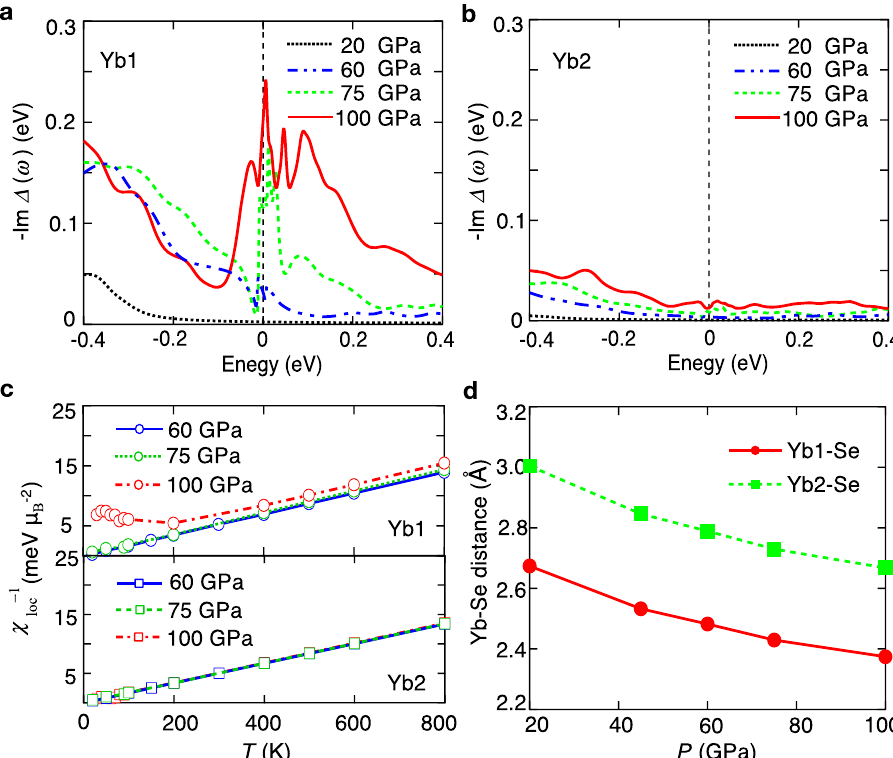
Fig. 3 Different properties of the two inequivalent Yb-ions. a , b Pressure evolution of the minus imaginary part of the hybridization function in real frequency on Yb1 and Yb2 ions from 20 to 100 GPa, obtained by DFT + DMFT calculations at 10 K. c Comparison of static local spin susceptibility of Yb1 and Yb2 4 f -electrons at 60, 75, and 100 GPa. d Comparison of the Yb-Se distances as a function of pressure from 20 to 100